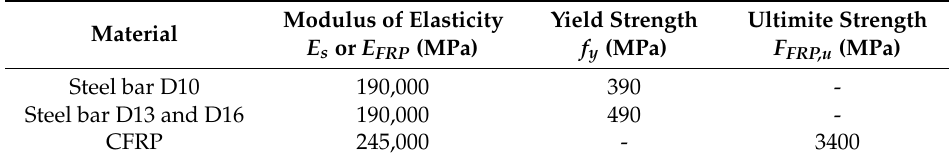
Table 2. Material properties of the reinforcement and carbon fiber–reinforced polymer (CFRP).